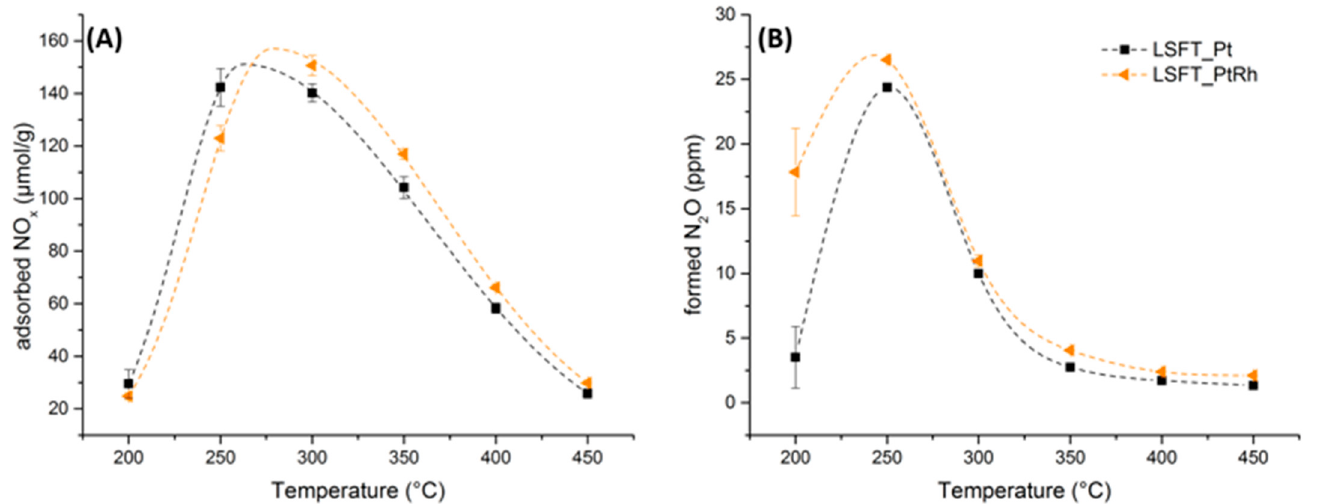
Figure 3. Temperature dependence of the ( A ) NO x storage capacity and ( B ) N 2 O formation of LSFT_PtRh. Data for LSFT_Pt from [44] also shown for comparison.